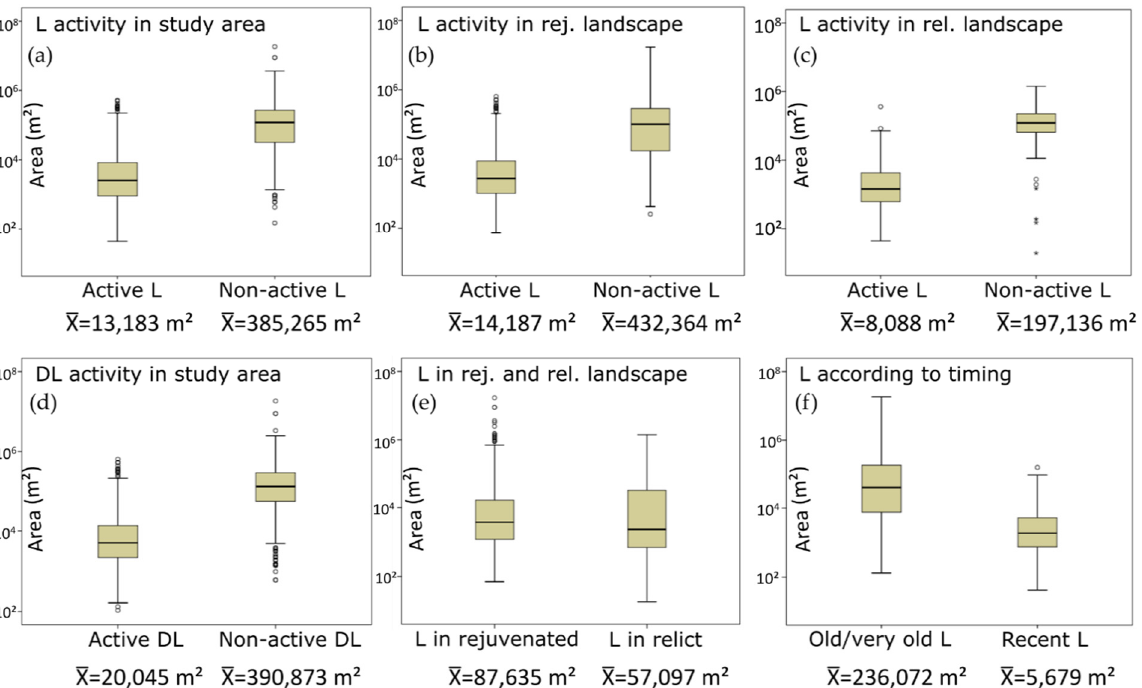
Figure 9. Boxplots showing the distribution of the landslide size (m 2 ) with regard to landslide (L) activity in ( a ) the entire study area; ( b ) the rejuvenated landscape (rej.), and ( c ) the relict landscape (rel.). ( d ) Boxplot comparing the distribution of deep-seated landslide (DL) size (m 2 ) in function of their activity in rejuvenated and relict landscape; ( e ) boxplot comparing the distribution of the landslide (L) size (m 2 ) in function of their position in the landscape (rejuvenated (rej.) or relict landscape (rel.)); ( f ) boxplot comparing the distribution of landslide (L) size (m 2 ) in function of their age. Boxplots give lower and upper quartiles and median. The whiskers of each box represent 1.5 times the interquartile range. Outliers beyond whiskers are shown as dots. For each boxplot, the average area of the landslides is provided.